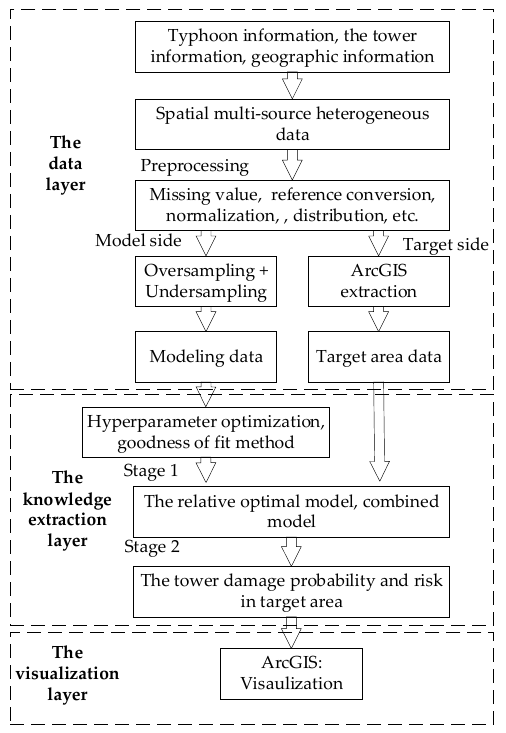
Figure 1. Overall structure of the method.